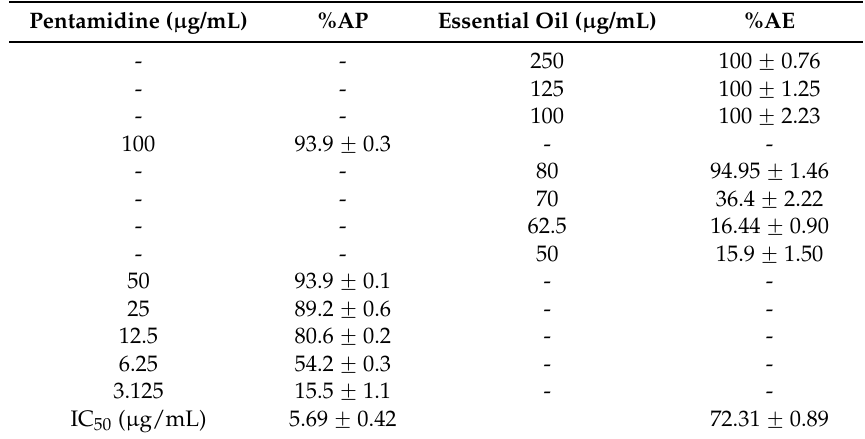
Table 3. Activity of L. camara leaf essential oil against Leishmania braziliensis .